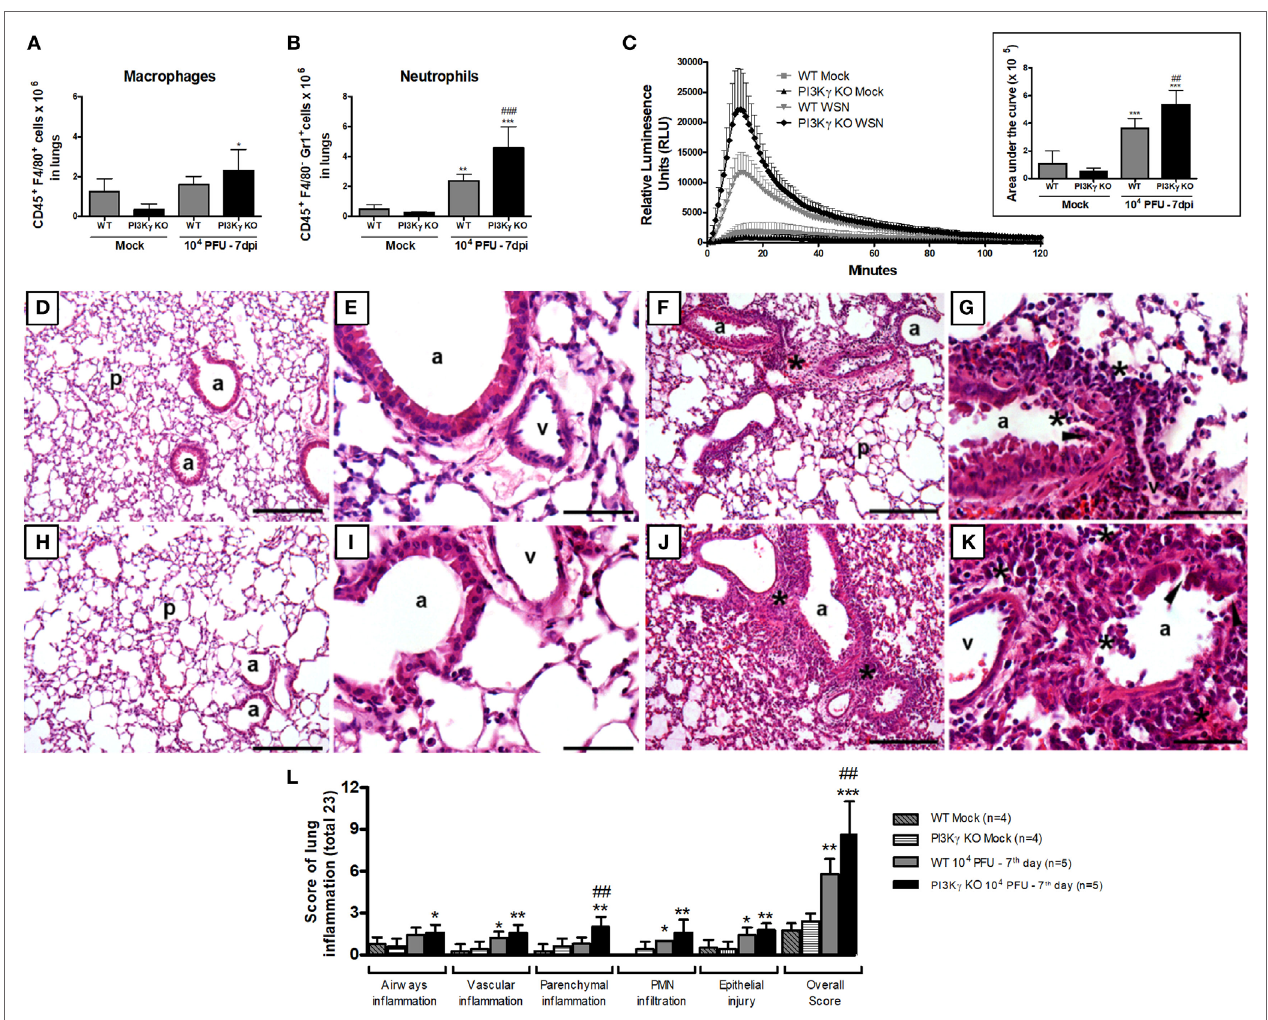
FigUre 8 | Neutrophil recruitment and activation and lung damage during influenza A virus infection are affected by phosphatidyl inositol 3 kinase-gamma (PI3K γ ). WT and PI3K γ knockout (KO) mice infected with 10 4 plaque-forming units (PFU) of WSN or receiving phosphate-buffered saline (Mock) were killed at day 7 after infection ( n = 4–7 mice per group). (a) Macrophage (CD45 + F4/80 + ) and (B) neutrophils (CD45 + F4/80 − GR1 + ) numbers in lungs assessed by flow cytometry. (c) Reactive oxygen species assessed in lung leukocytes in presence of luminol with or without zymosan for 120 min. Relative luminescence units mean the value with zymosan minus the respective value without zymosan. Areas under the curve were compared using mean ± SEM and one-way ANOVA, Newman–Keuls test (D–K) . Representative slides of hematoxylin and eosin stained lung sections from WT (D, e) and PI3K γ KO mock (h,i) , WT (F,g) , and PI3K γ KO-infected mice (J,K) are shown in 100 × [ (D,h,F,J) , bars = 200 μ m] and 400 × [ (e,i,g,K) , bars = 50 μ m] magnification. “p” Indicates lung parenchyma, “v” vessels, and “a” airways; asterisks foci of inflammatory infiltrates; and arrowheads areas of epithelial injury. (l) Histopathological score (total 23 points) assessed airway, vascular, parenchymal inflammation, neutrophilic infiltration, and epithelial injury. Data are presented as mean ± SD. * p < 0.05, ** p < 0.01, and *** p < 0.001, compared with each Mock group; ## p < 0.01 and ### p < 0.001, compared with WT-infected mice (one-way ANOVA,